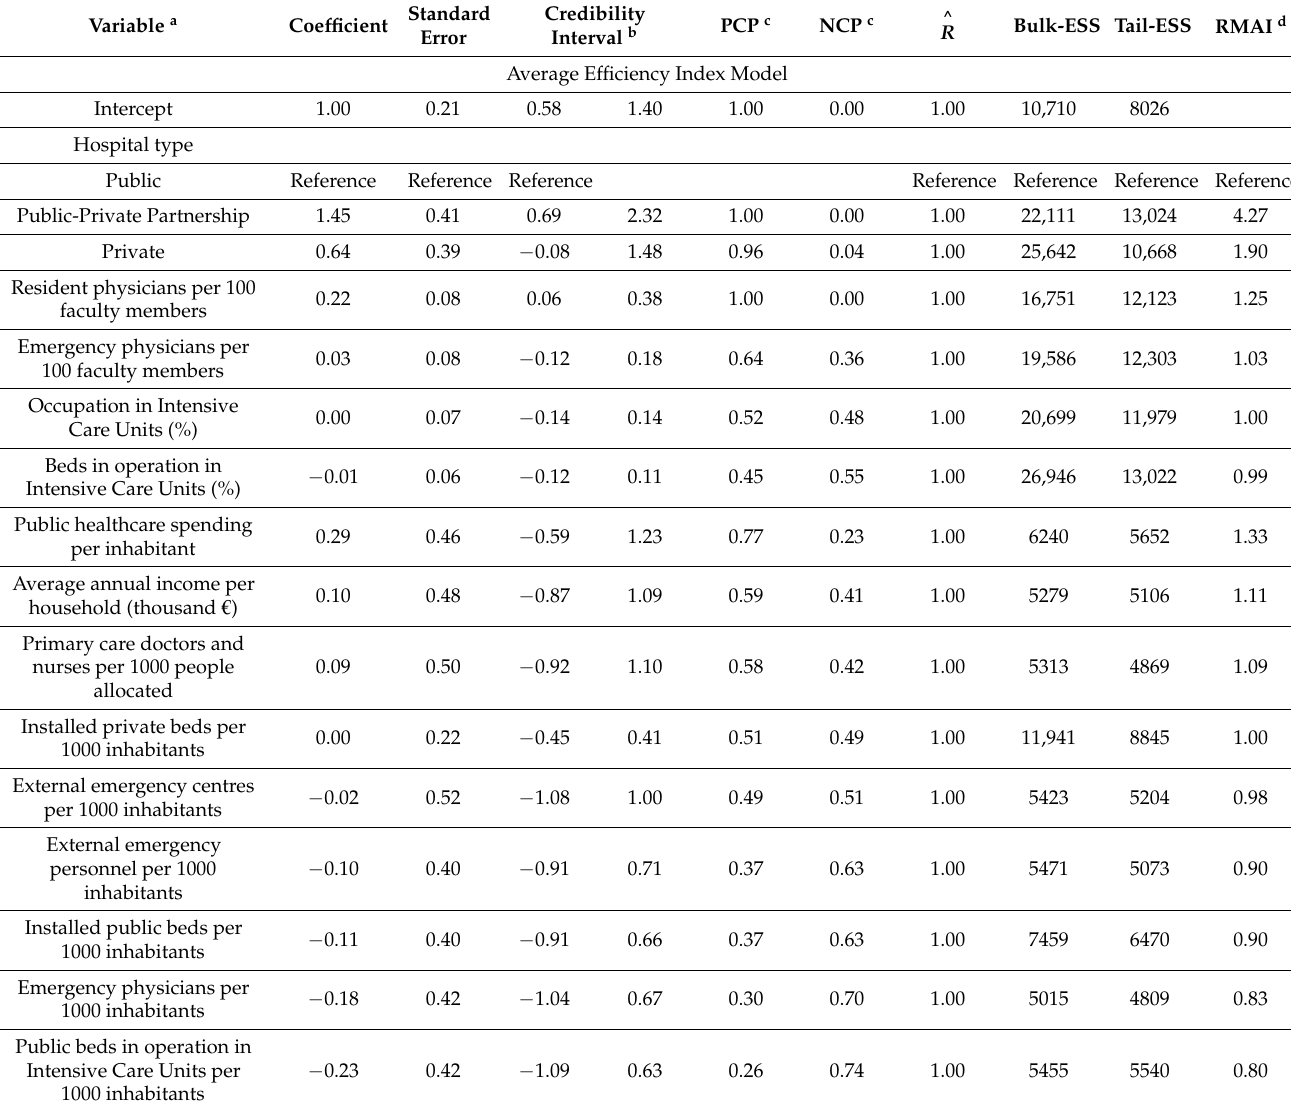
Table 3. Relationship between categorized independent variables and the technical efficiency of the Spanish National Health System hospitals,